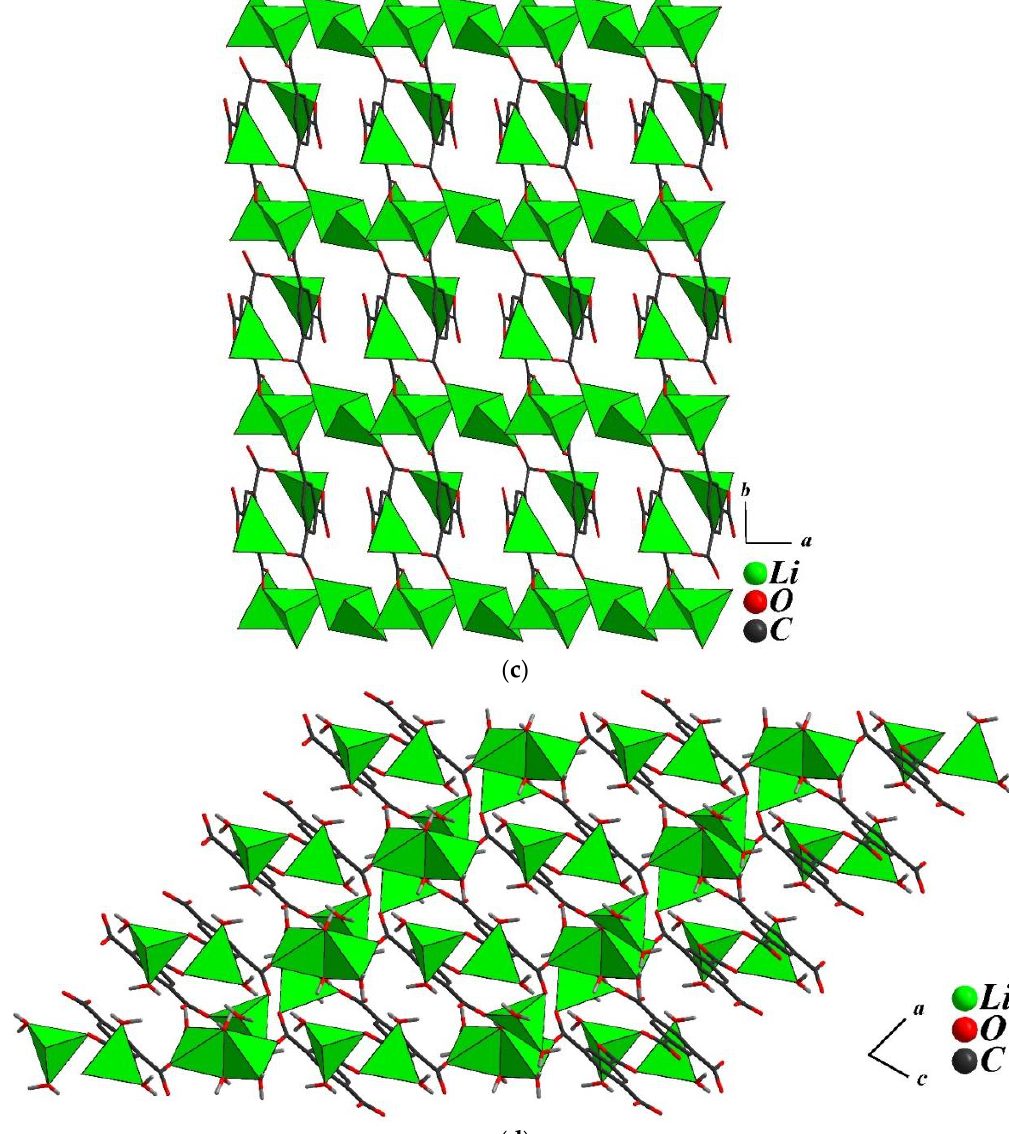
Figure 1. ( a ) The coordination spheres of lithium atoms in 1 ; ( b ) the coordination model of the BTC ligand in 1 ; ( c ) the one-layer structure view of 1 (H atoms were omitted for clarity). ( d ) The 2-D sheets viewed along the b -axis of 1 .